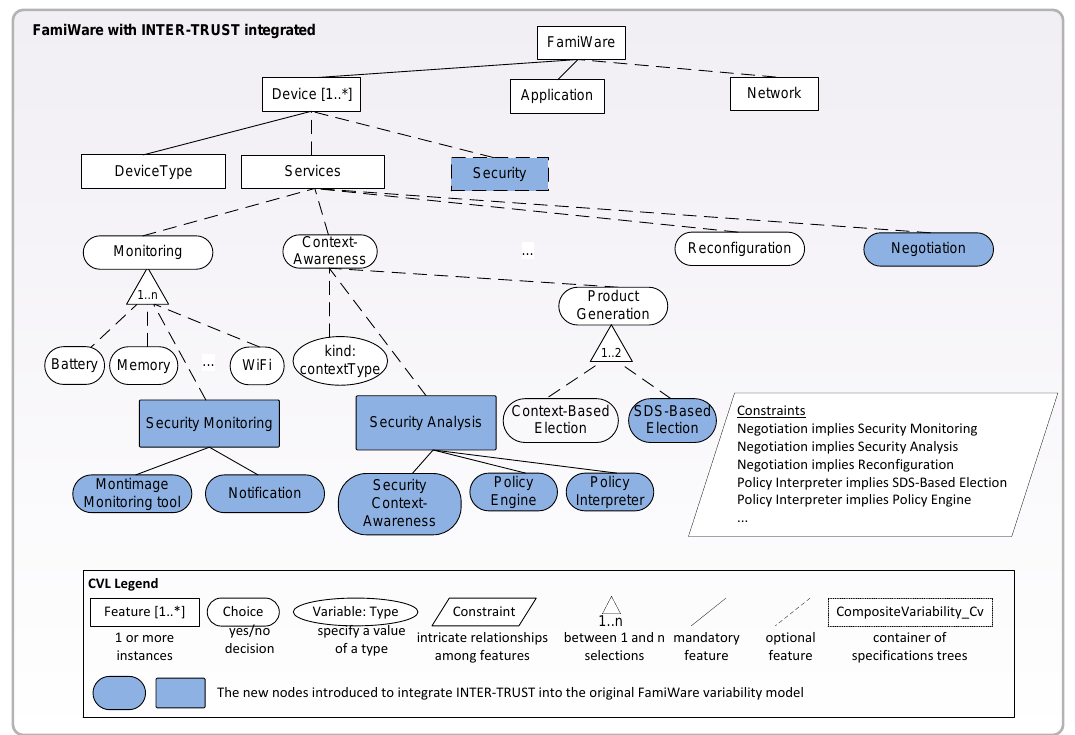
Figure 5. FamiWare + INTER-TRUST variability